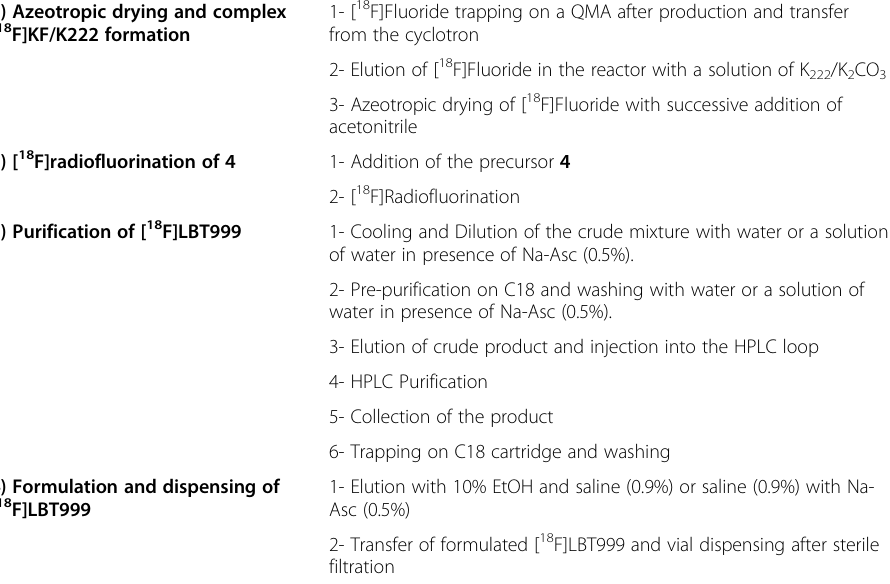
Table 1 Common steps for the automated radiosynthesis of [ 18 F]LBT999 on TRACERlab FXFN and AIO